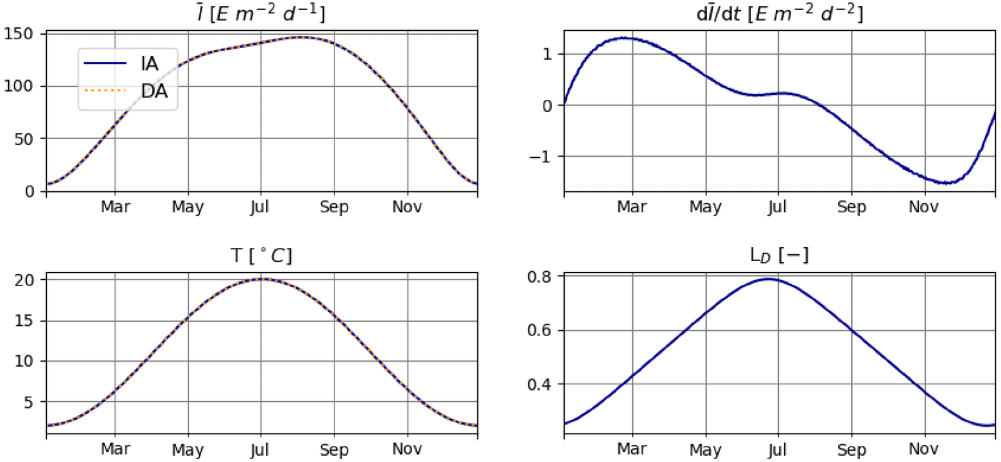
Figure 3. Daily average irradiance and temperature and their numerically approximated temporal derivatives used in